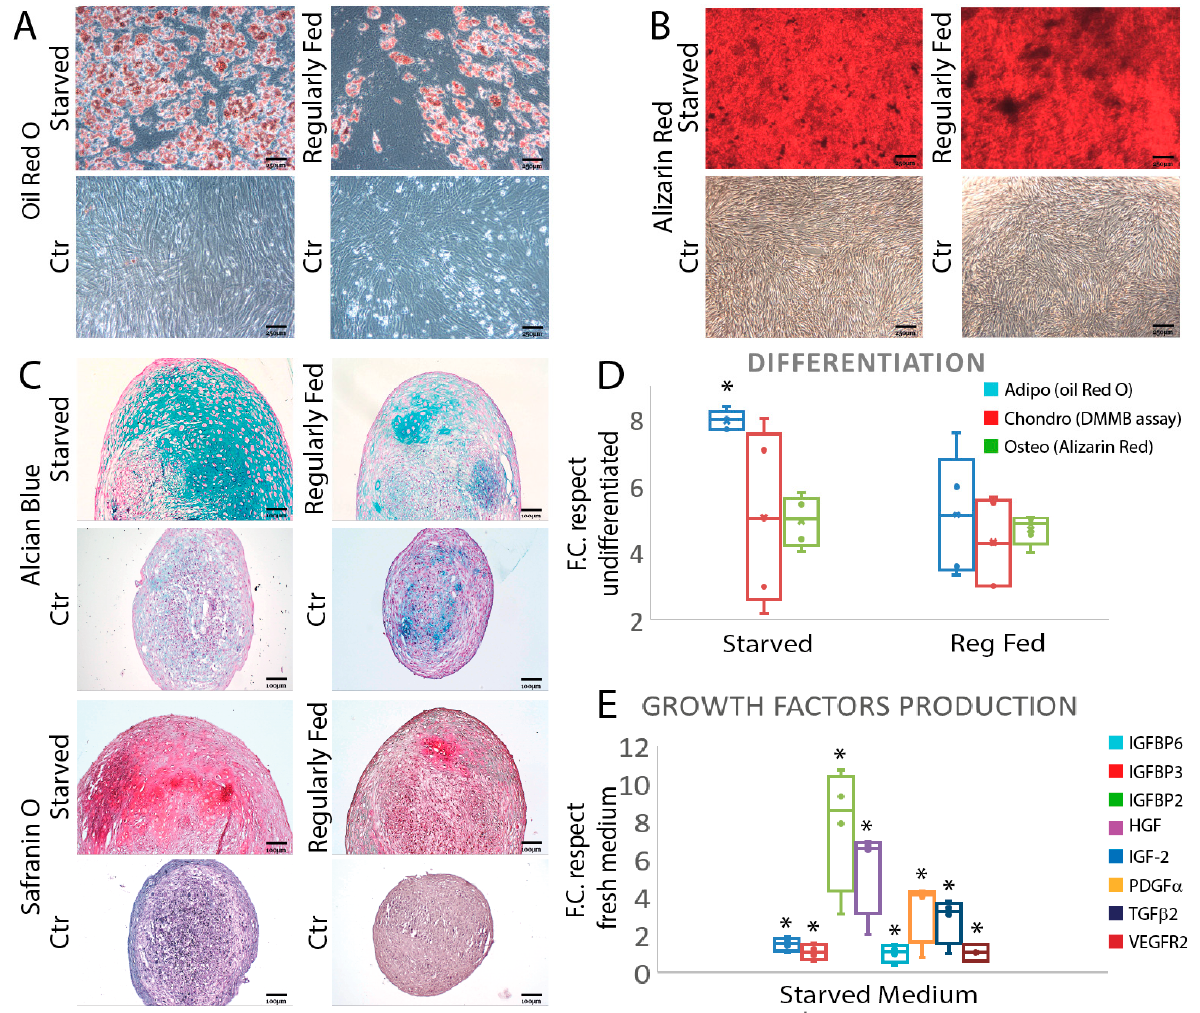
Figure 2. Starved cells retain their ability to differentiate and survive secreting trophic factors: ( A ) Oil red O staining comparing the hBM-MSC adipocytic differentiation potential in regularly fed and starved cell populations. ( B ) Alizarin red staining showing the osteoblastic potential of the tested cells in the same groups of A. ( C ) Alcian blue and safranin O staining evidencing the chondroblastic potential of the starved and regularly fed cells. ( D ) Whisker plot comparing the differentiation potential of the tested hBM-MSC. Results are normalized with respect to control cells cultured in proliferation medium. Results are presented as mean ± SD of three independent experiments. * p ≤ 0.05